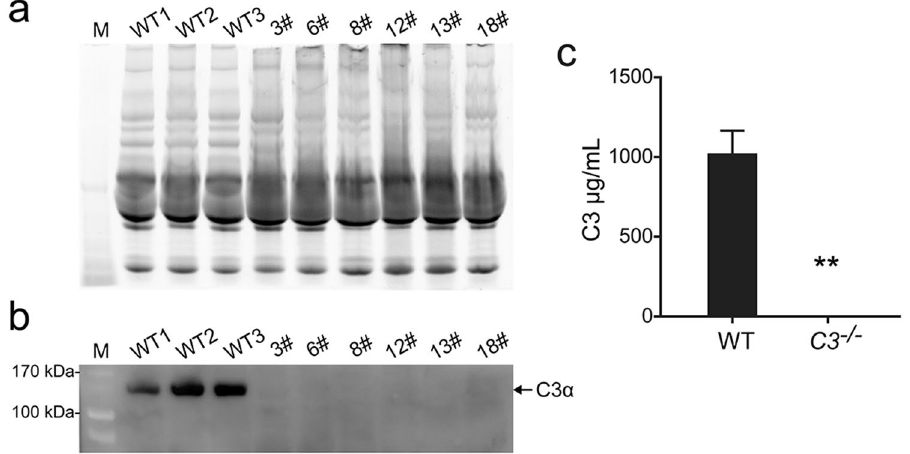
Figure 3. C3 protein expression analysis of piglet serum. ( a ) Stain-free gel image of total loaded serum proteins. ( b ) Western blot of serum C3 protein of cloned piglets compared to that of wild type piglets. Full-length blot is presented in Supplementary Figure S3. ( c ) Serum C3 protein levels of C3 KO piglets and wild type controls were assessed by ELISA ( ** P < 0.01, data are shown as mean ± SEM, n = 3).